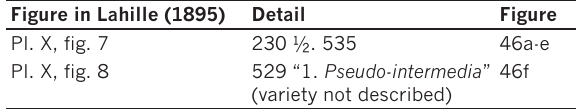
Table 18. Specimens of Voluta oviformis fratercula figured in Lahille (1895) with the detail of the inscriptions on their shells and figures here.